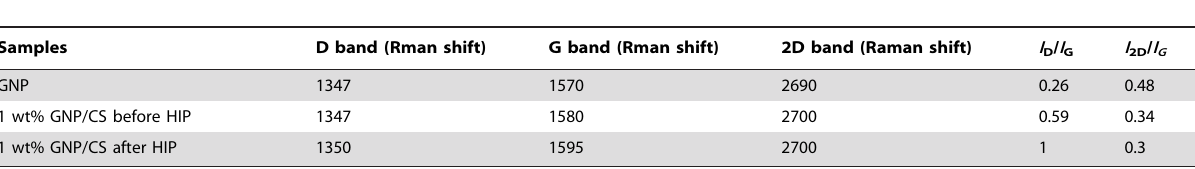
Table 1. Peak position of the D and G bands and intensity ratios of I D / I G and I 2D / I G .